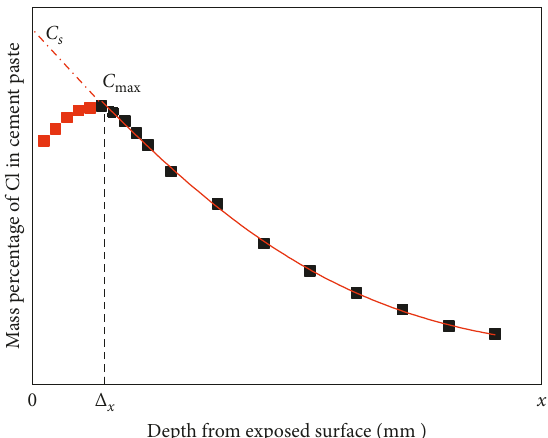
Figure 1: Illustration of chloride profile with the appearance of a chloride concentration peak ( C max is the peak value of chloride content or the maximum chloride content, and Δ x is the depth at which C max appears)